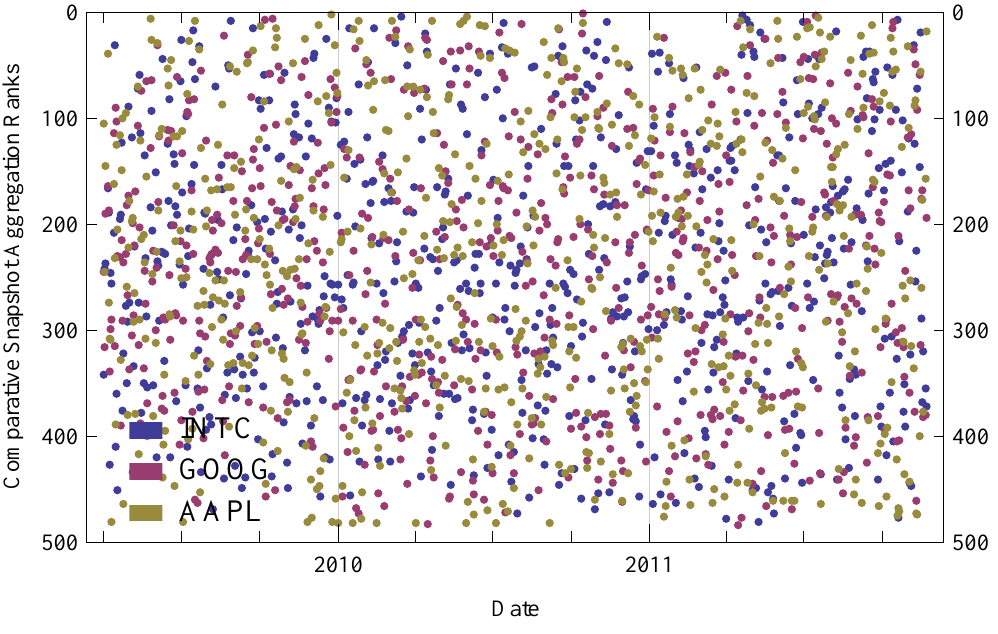
Figure 11. Snapshot aggregation rank of our three stocks over the time period